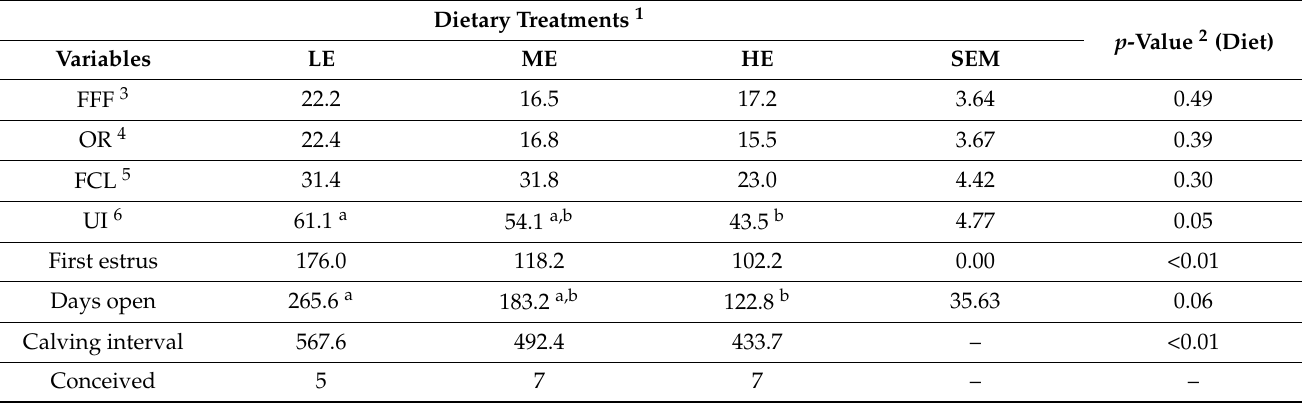
Table 5. Postpartum reproductive performance of Nili Ravi buffaloes fed different levels of energy.